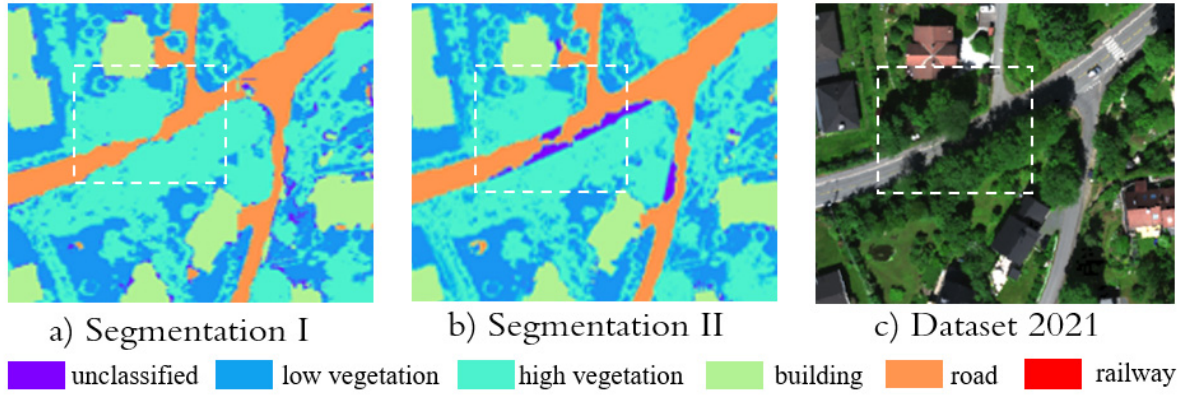
Figure 13. An example of vegetation covering the road marked with a white dashed rectangle.